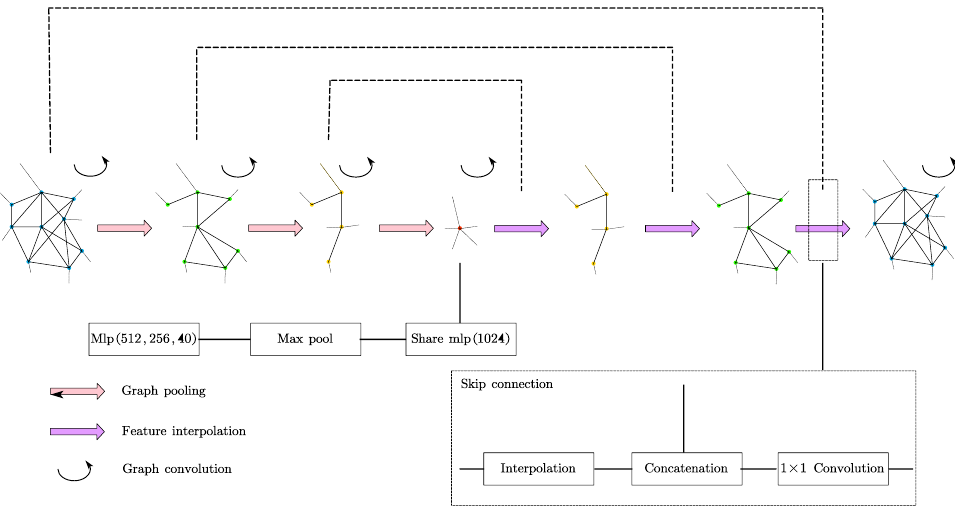
Figure 2. The architecture of AP-GCN .